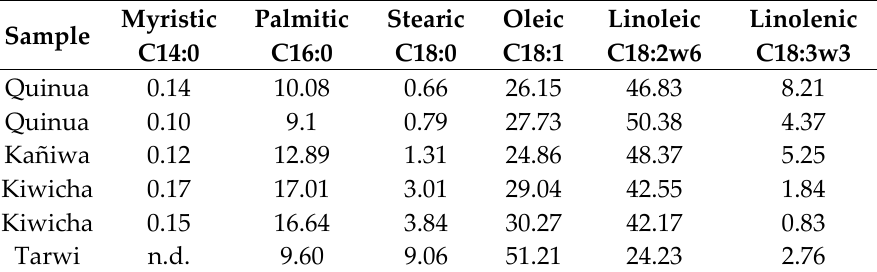
Table 2. Fatty acid composition of Andean grains (% of total fatty